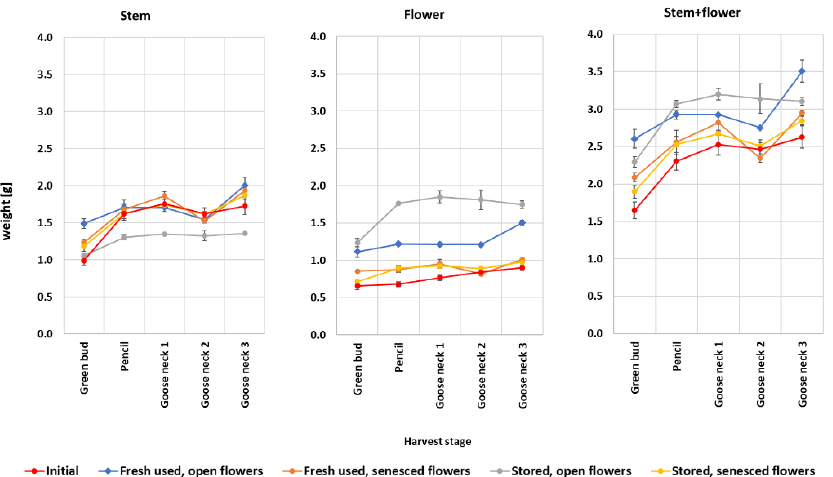
Figure 12. Fresh weight of plant organs. Bud stages: green bud (GB); pencil: white bud, upright (PE); goose neck 1: white bud, skew (GN1); goose neck 2: white bud, horizontal (GN2); goose neck 3: big white bud, horizontal, maximum with 1 opening petal (GN3).